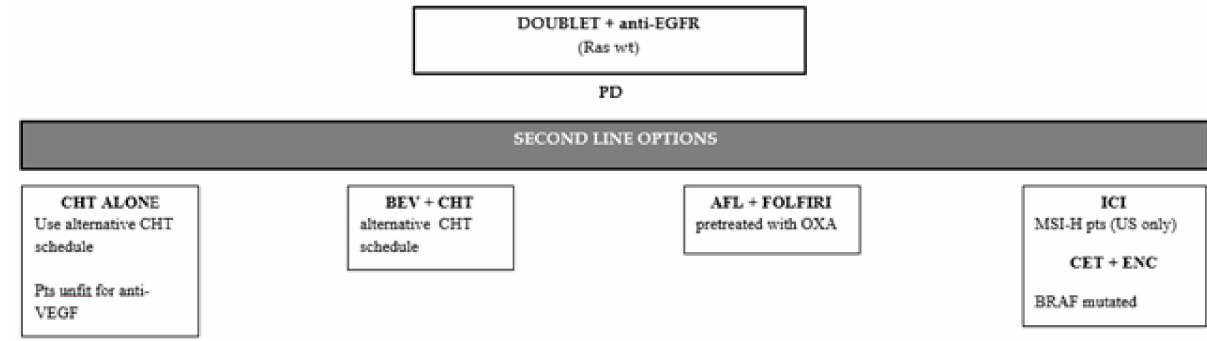
Figure 2. Second-line therapeutic options after disease progression to a doublet + anti-EGFR first line therapy. PD: progression disease; BEV: Bevacizumab; CHT: chemotherapy; wt: wild-type; FP: fluoropyrimidines; AFL: Aflibercept; OXA: Oxaliplatin; FP: fluoropyrimidines; ICI: immune-checkpoint inhibitors; US: United States; CET: Cetuximab; ENC: